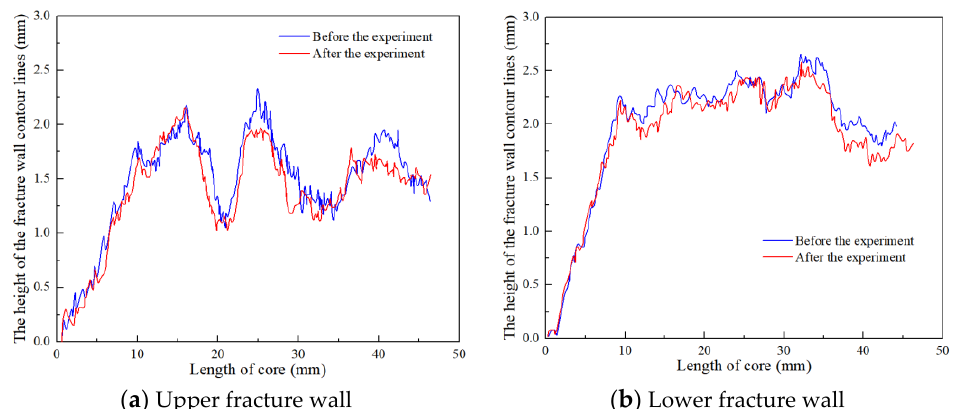
Figure 5. The comparison of the height of the fracture wall contour lines of the fracture core samples before and after the experiment.